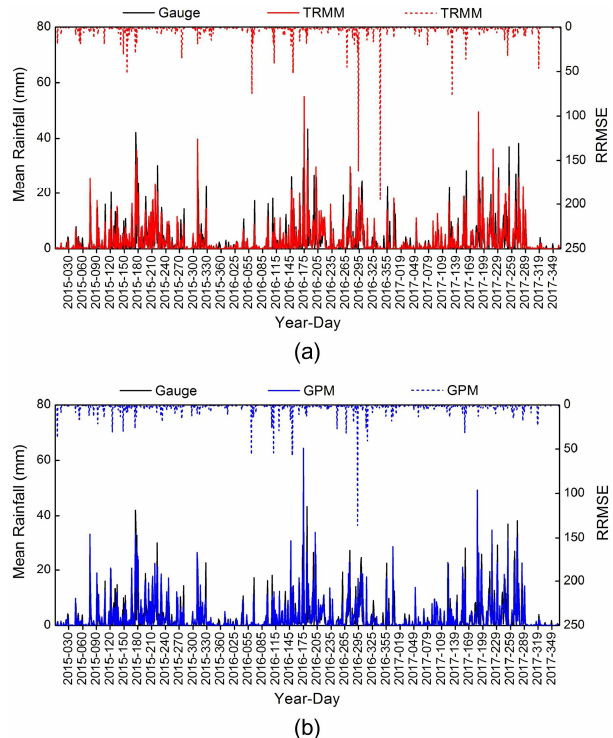
Figure 3. Time series of RRMSE (dash line) and mean daily precipitation (solid line) from 2015 to 2017 over the Huaihe River basin: ( a ) TRMM 3B42 v7, ( b ) GPM IMERG v5.